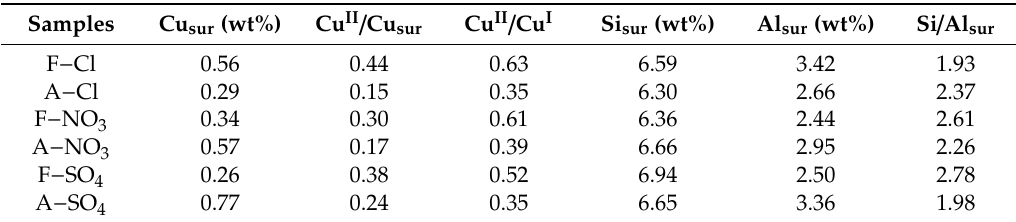
Table 5. Cu 2p 3 / 2 XPS curve-fitting results of Cu II − SSZ − 13 catalysts before and after